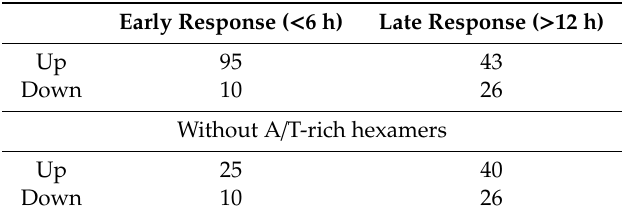
Table 1. Summary of predicted hexamers associated with cold stress response in